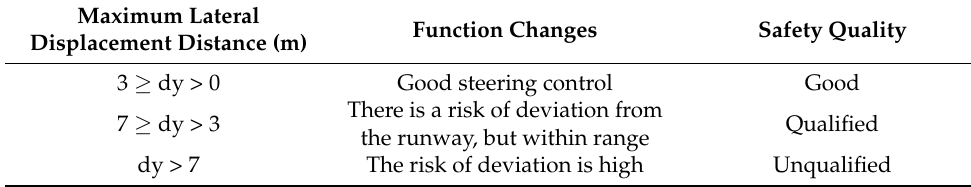
Table 8. Functional changes in “F2: rudder” (2).